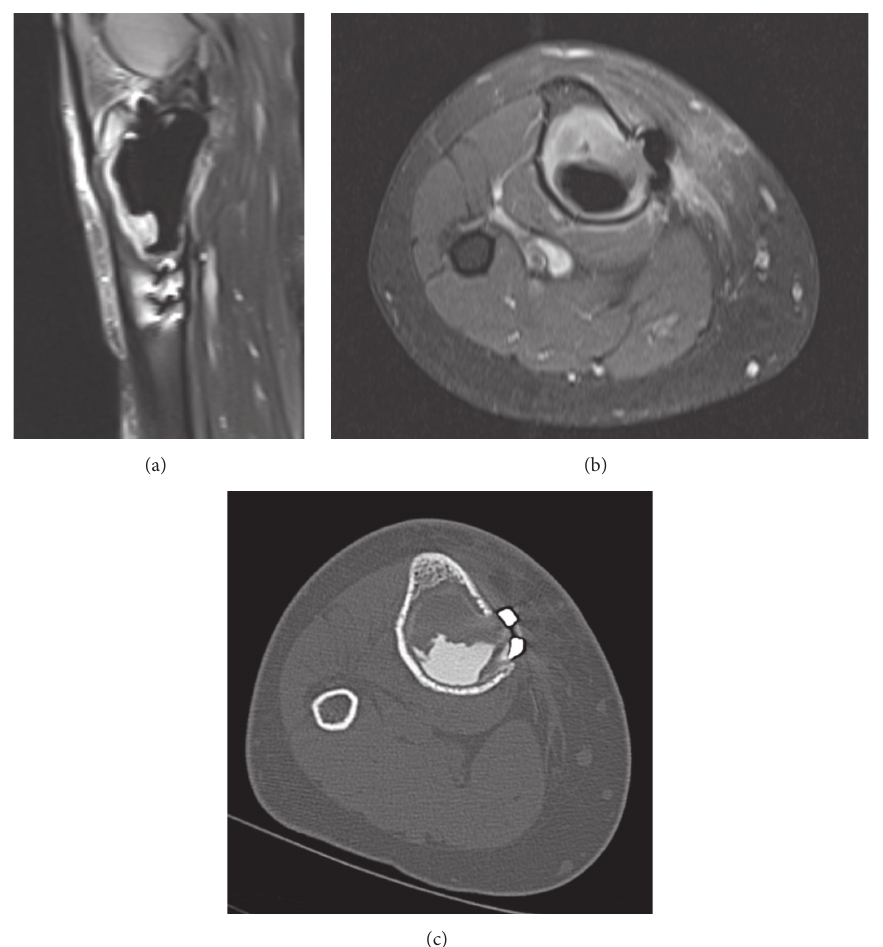
Figure 9: Sagittal T2 weighted fat suppressed image (a) and axial postcontrast enhanced T1 weighted image (b) of the right knee 3 months after the giant cell tumor curettage and packing demonstrate area of T2 hyperintensity and associated enhancement anterior to the surgical curettage cavity. CT scan image (c) from the same date also shows that there is corresponding uncemented area.